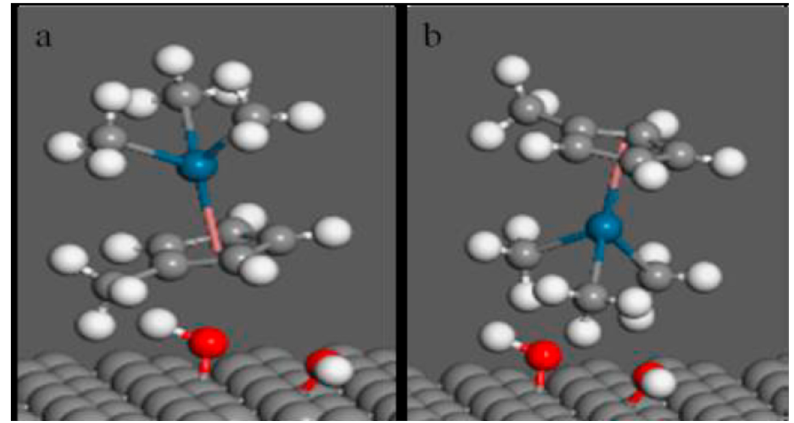
Figure 8: Primary orientations of MeCpPtMe 3 on a hydroxylated graphene surface models ( a and b ) . ( Grey = carbon, blue = platinum, red = oxygen, and white = hydrogen atoms ) [ 19 ] .